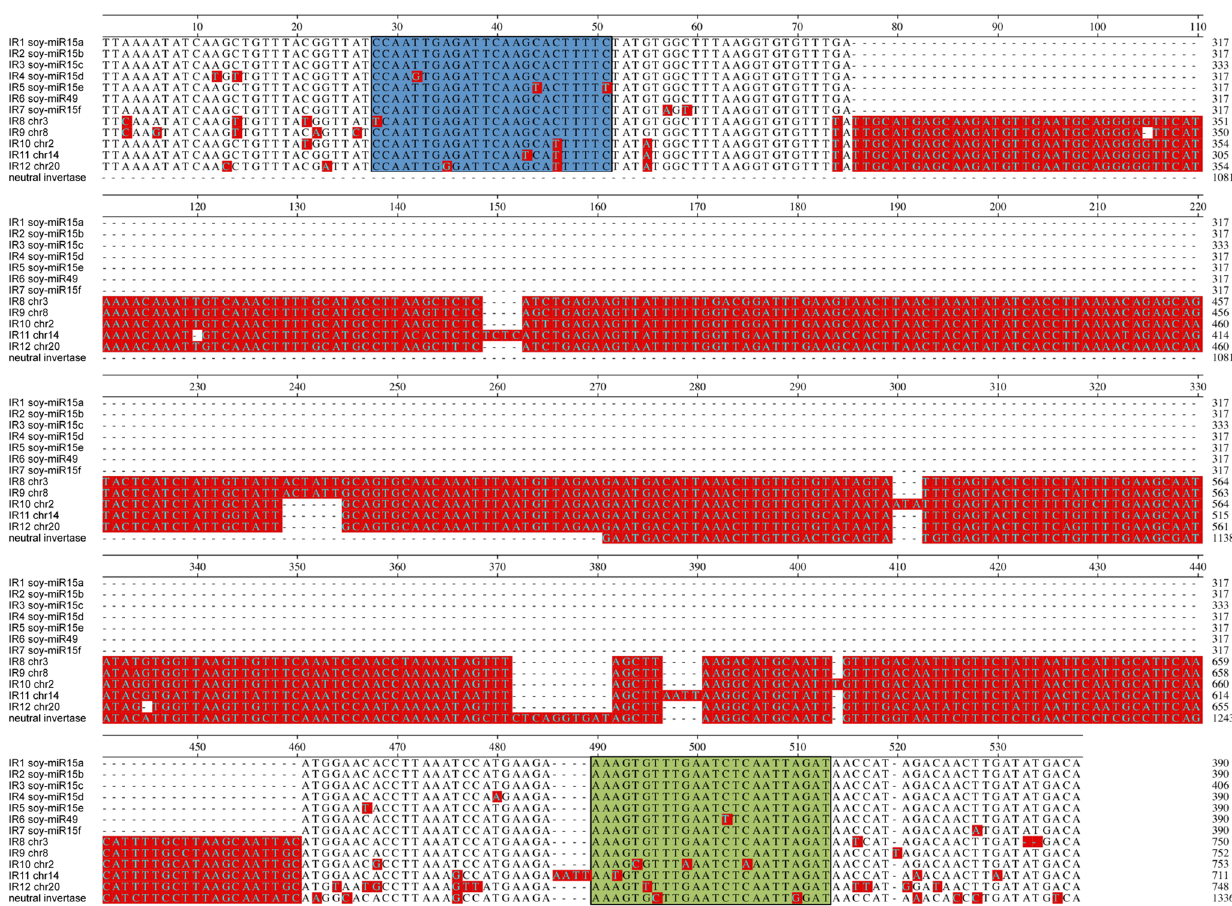
Figure 4. Sequence Alignment of Inverted Repeats and a Neutral Invertase Gene. The central regions of the inverted repeat sequences 1 to 8, their homologous IR sequences from chromosomes 8, 2, 14 and 20 and a fragment of a neutral invertase gene (Glyma12g02690) were aligned. The miRNA and miRNA star sequences are highlighted in green and blue, respectively. Nucleotides that differ from the consensus sequence are shaded in red.